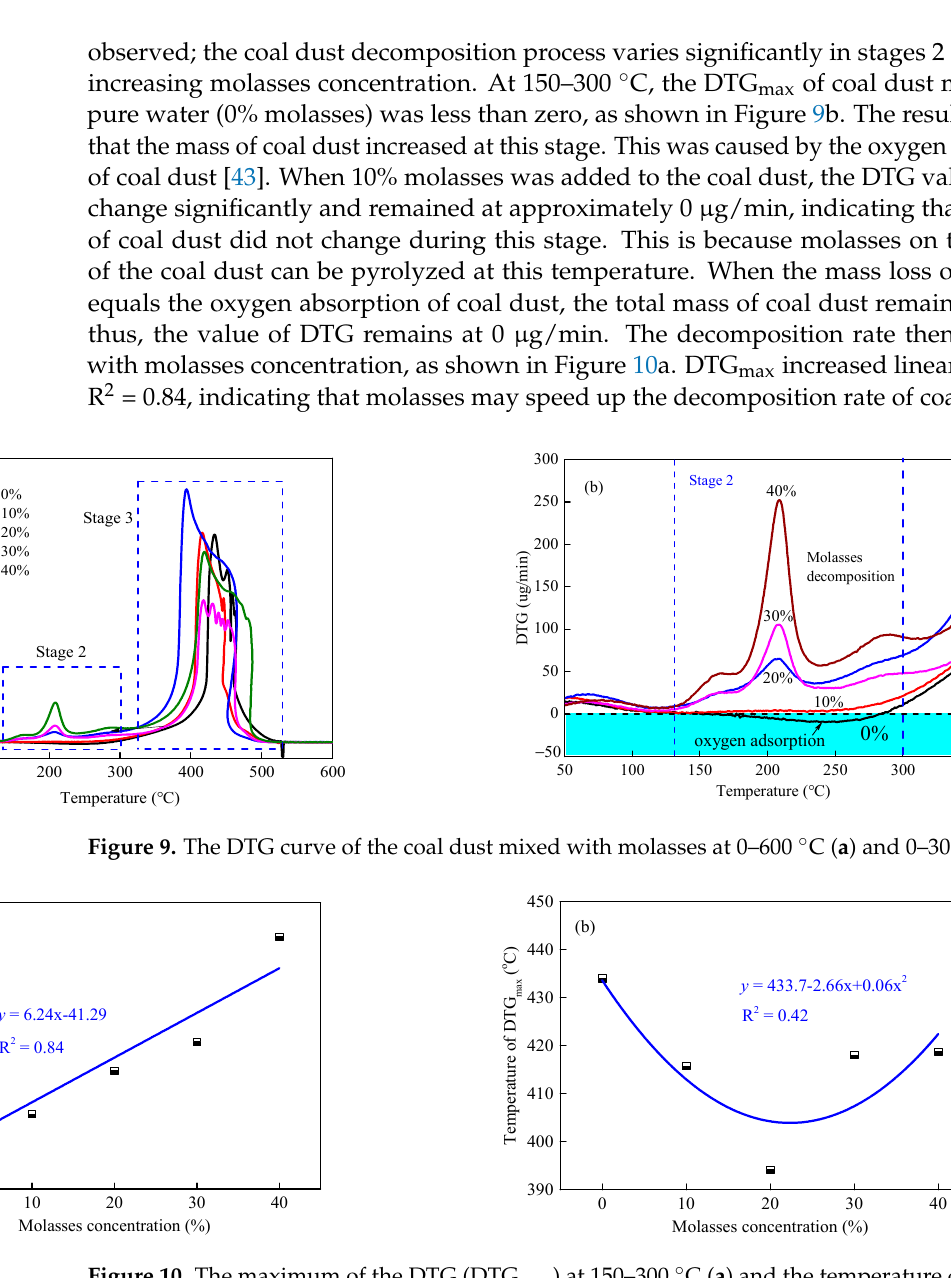
Figure 8. The mass fraction of the coal dust at 0–600 °C ( a ) and 0–300 °C ( b ).